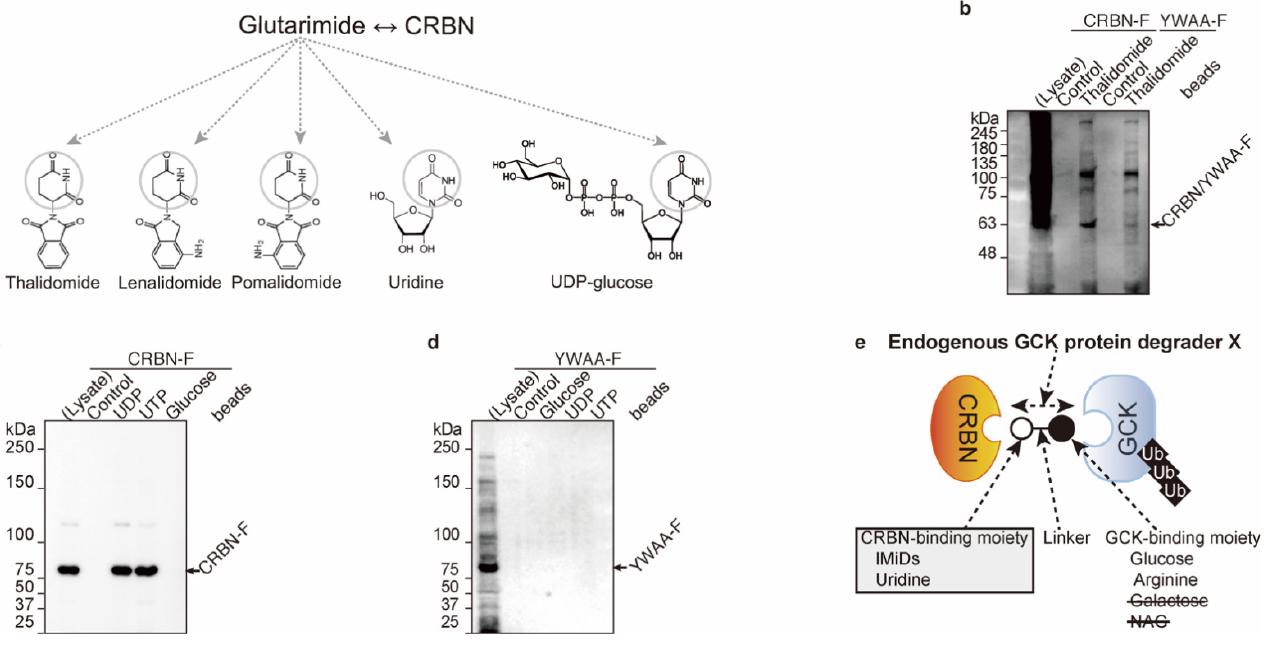
Figure 2. Uridine binds to cereblon (CRBN). ( a ) Glutarimide moiety (gray circles) in the IMiDs (thalidomide, lenalidomide, and pomalidomide), uridine, and UDP-glucose. ( b – d ) Cereblon binds to uridine and thalidomide. CRBN WT proteins were mixed with control, thalidomide-immobilized beads ( b ), UDP and UTP-immobilized beads ( c ), control, and non-thalidomide-binding mutant CRBN YWAA was mixed with control, thalidomide ( b ), UDP, and UTP ( d )-immobilized beads. CRBN WT binds to UDP, UTP, and thalidomide through Y384 and W386 residues. ( e ) Graphic summary Cereblon-binding moiety of endogenous glucokinase protein X was uridine.